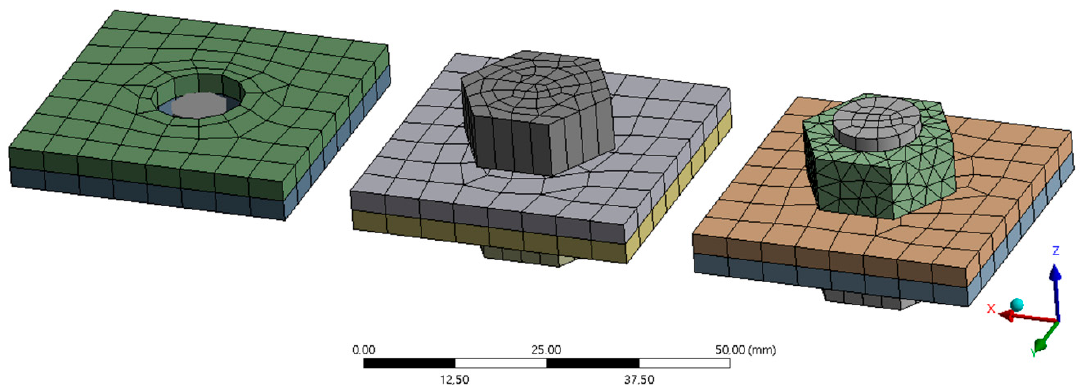
Figure 8. Numerical models of bolted joints—from the left a beam model, a volume with a shell and a full-volume bolt model.